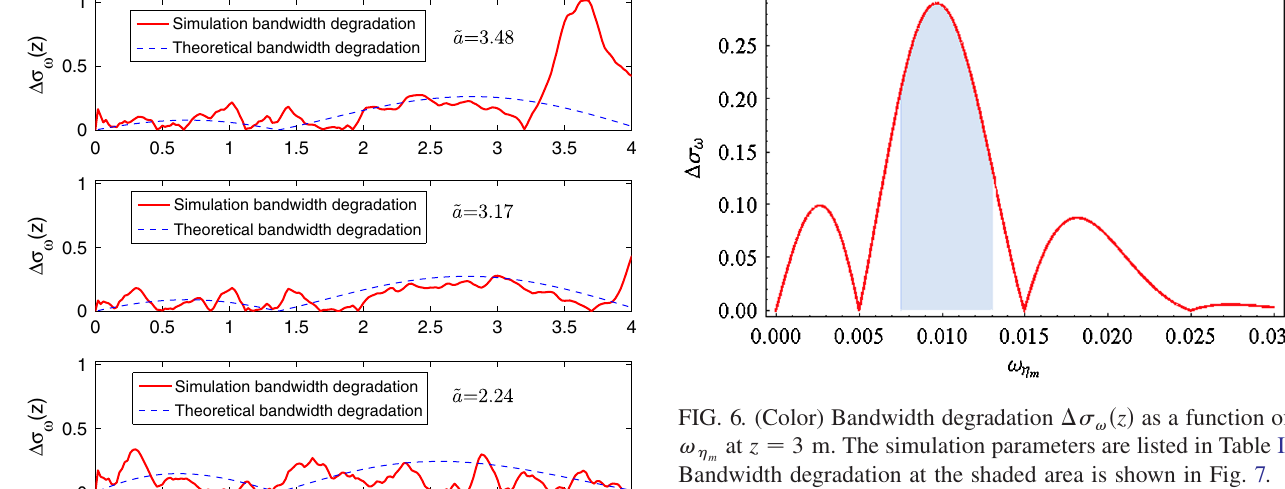
FIG. 6. (Color) Bandwidth degradation (cid:2) (cid:10) ! at z ¼ 3 m . The simulation parameters are listed in Table I. (cid:7) m Bandwidth degradation at the shaded area is shown in Fig. 7.